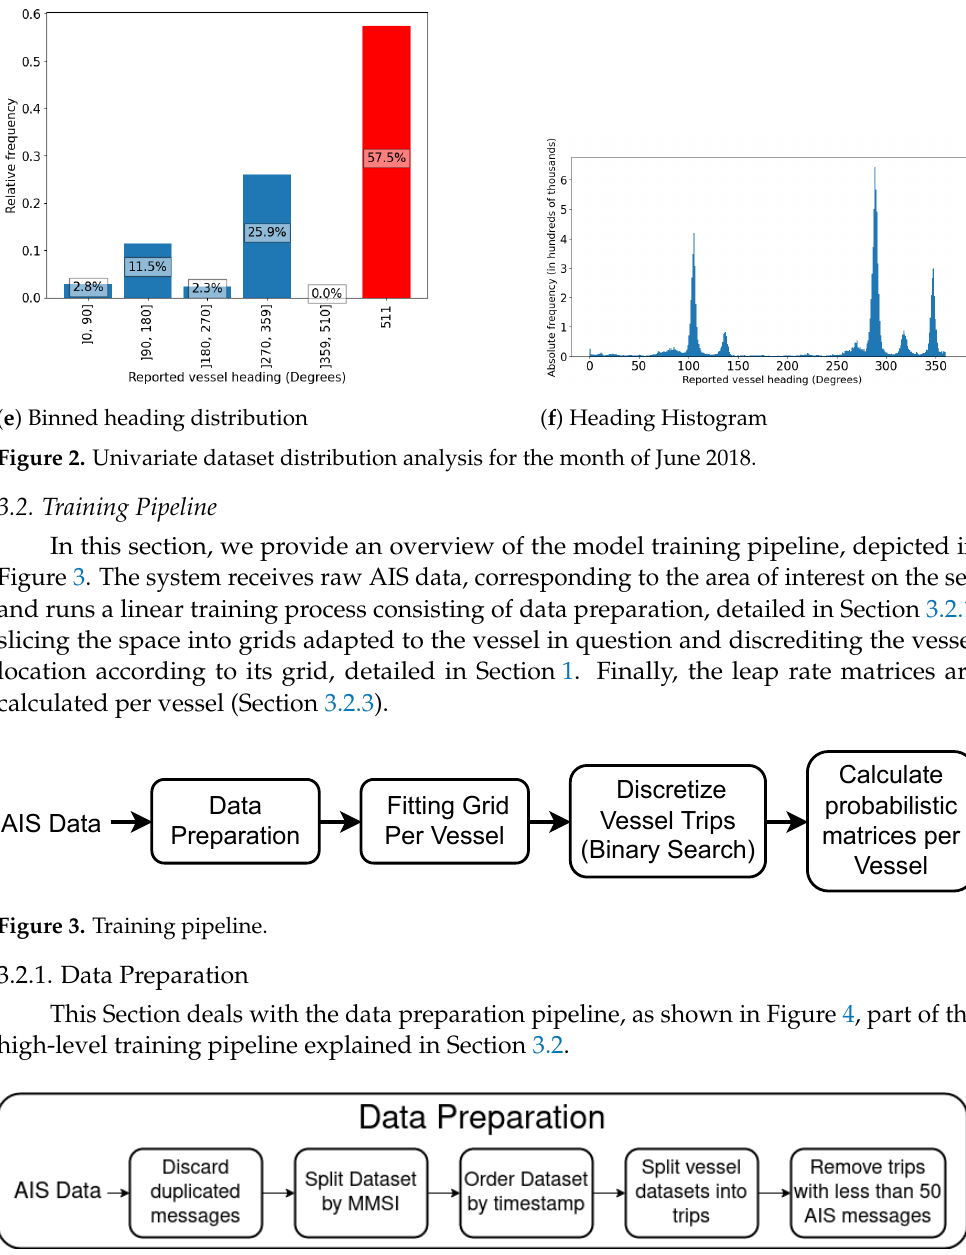
Figure 4. Data preparation